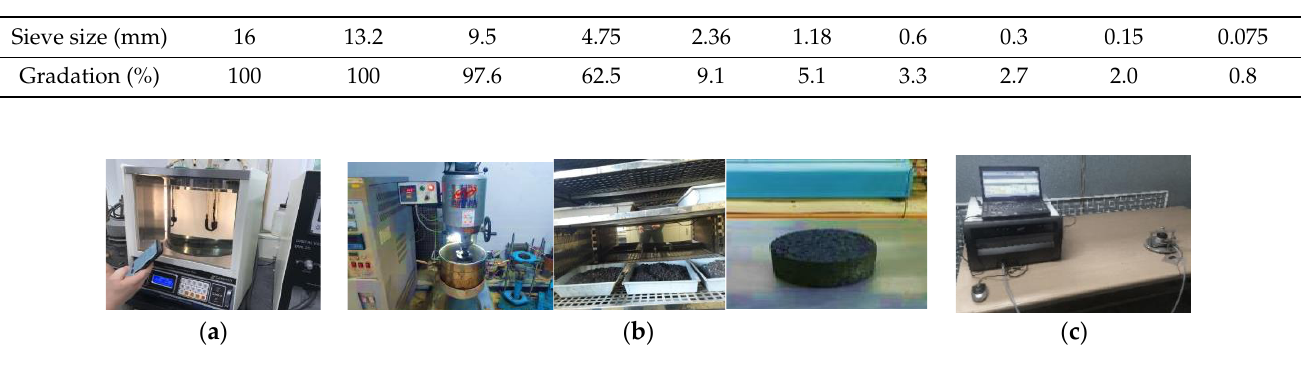
Figure 2. Illustration of laboratory test. ( a ) absolute viscosity; ( b ) Test specimen fabrication of Guss mastic asphalt mixtures; ( c ) Thermal conductivity test.